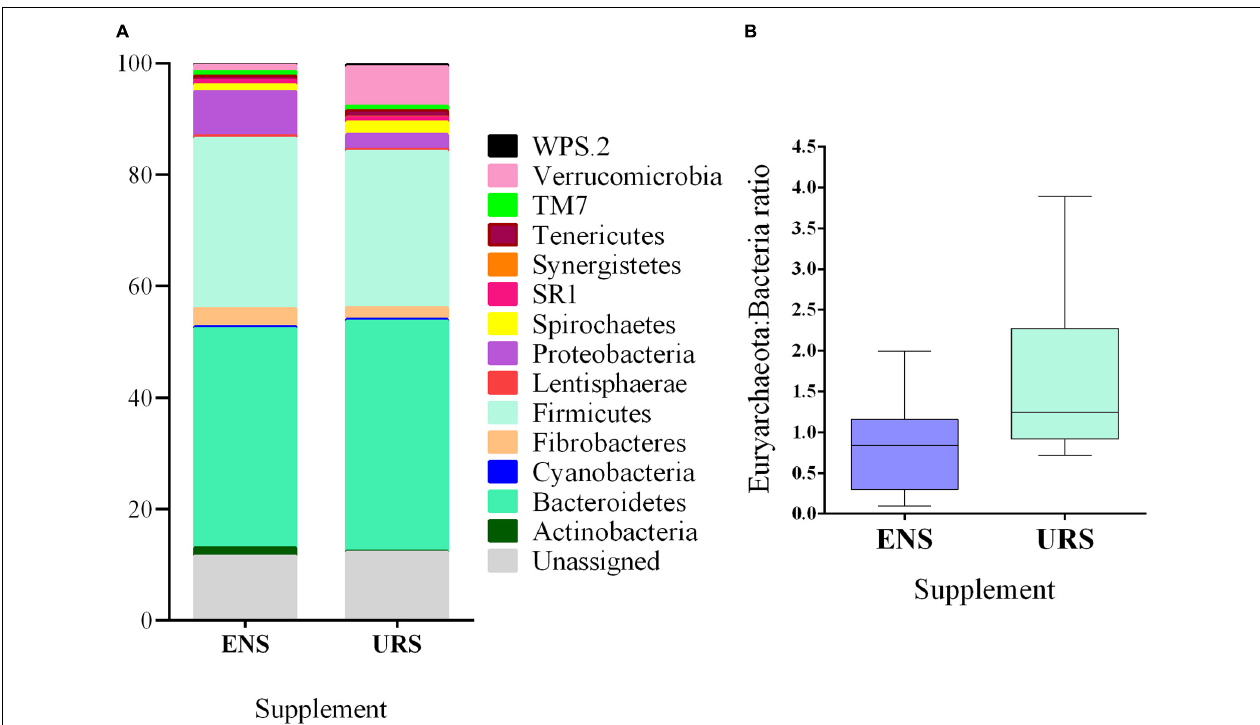
FIGURE 2 | Bacterial abundance at phylum level (A) and Euryarchaeota: Bacteria ratio (B) in grazing Nellore Steers after a long time (13 months) of supplementation with encapsulated nitrate (ENS) or Urea